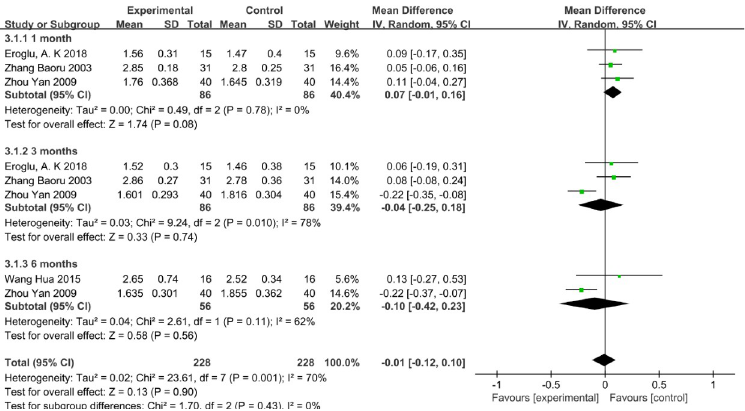
Fig 8. The status of SPD index at 1, 3, and 6 months between the VFR group and the Hawley group.